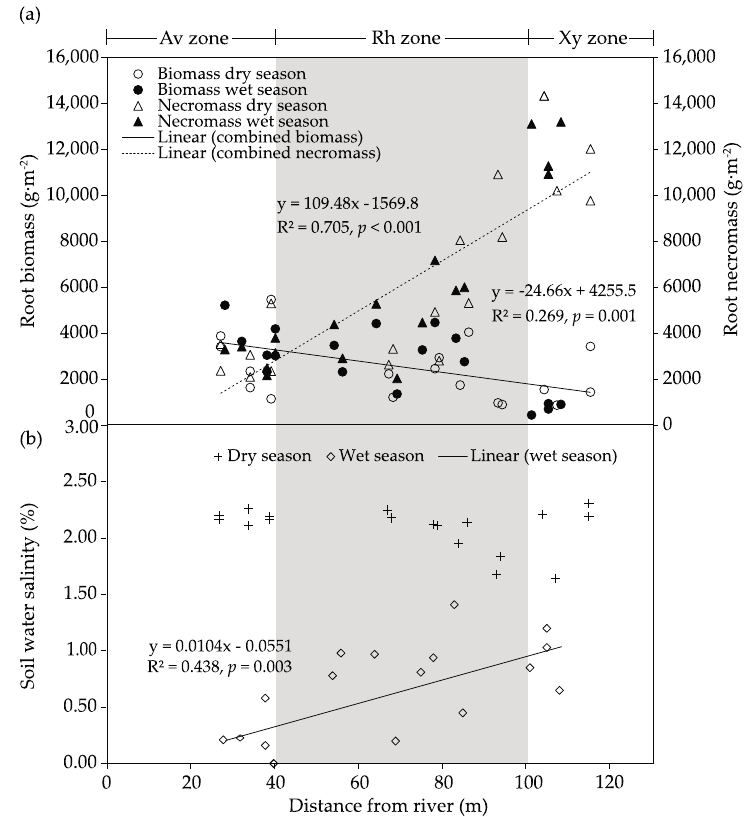
Figure 4. The linear relationships between total root mass (biomass and necromass) ( a ) and soil water salinity ( b ) along distance from the river across the zonation: Avicennia (Av), Rhizophora (Rh), and Xylocarpus (Xy) zones. The regression lines show the significant regression models.